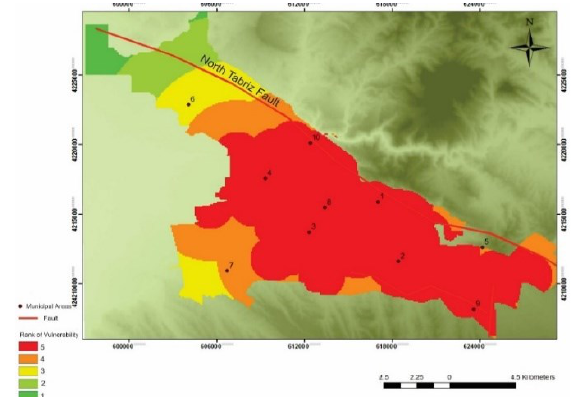
Table 11. Vulnerability and its ranking based on range